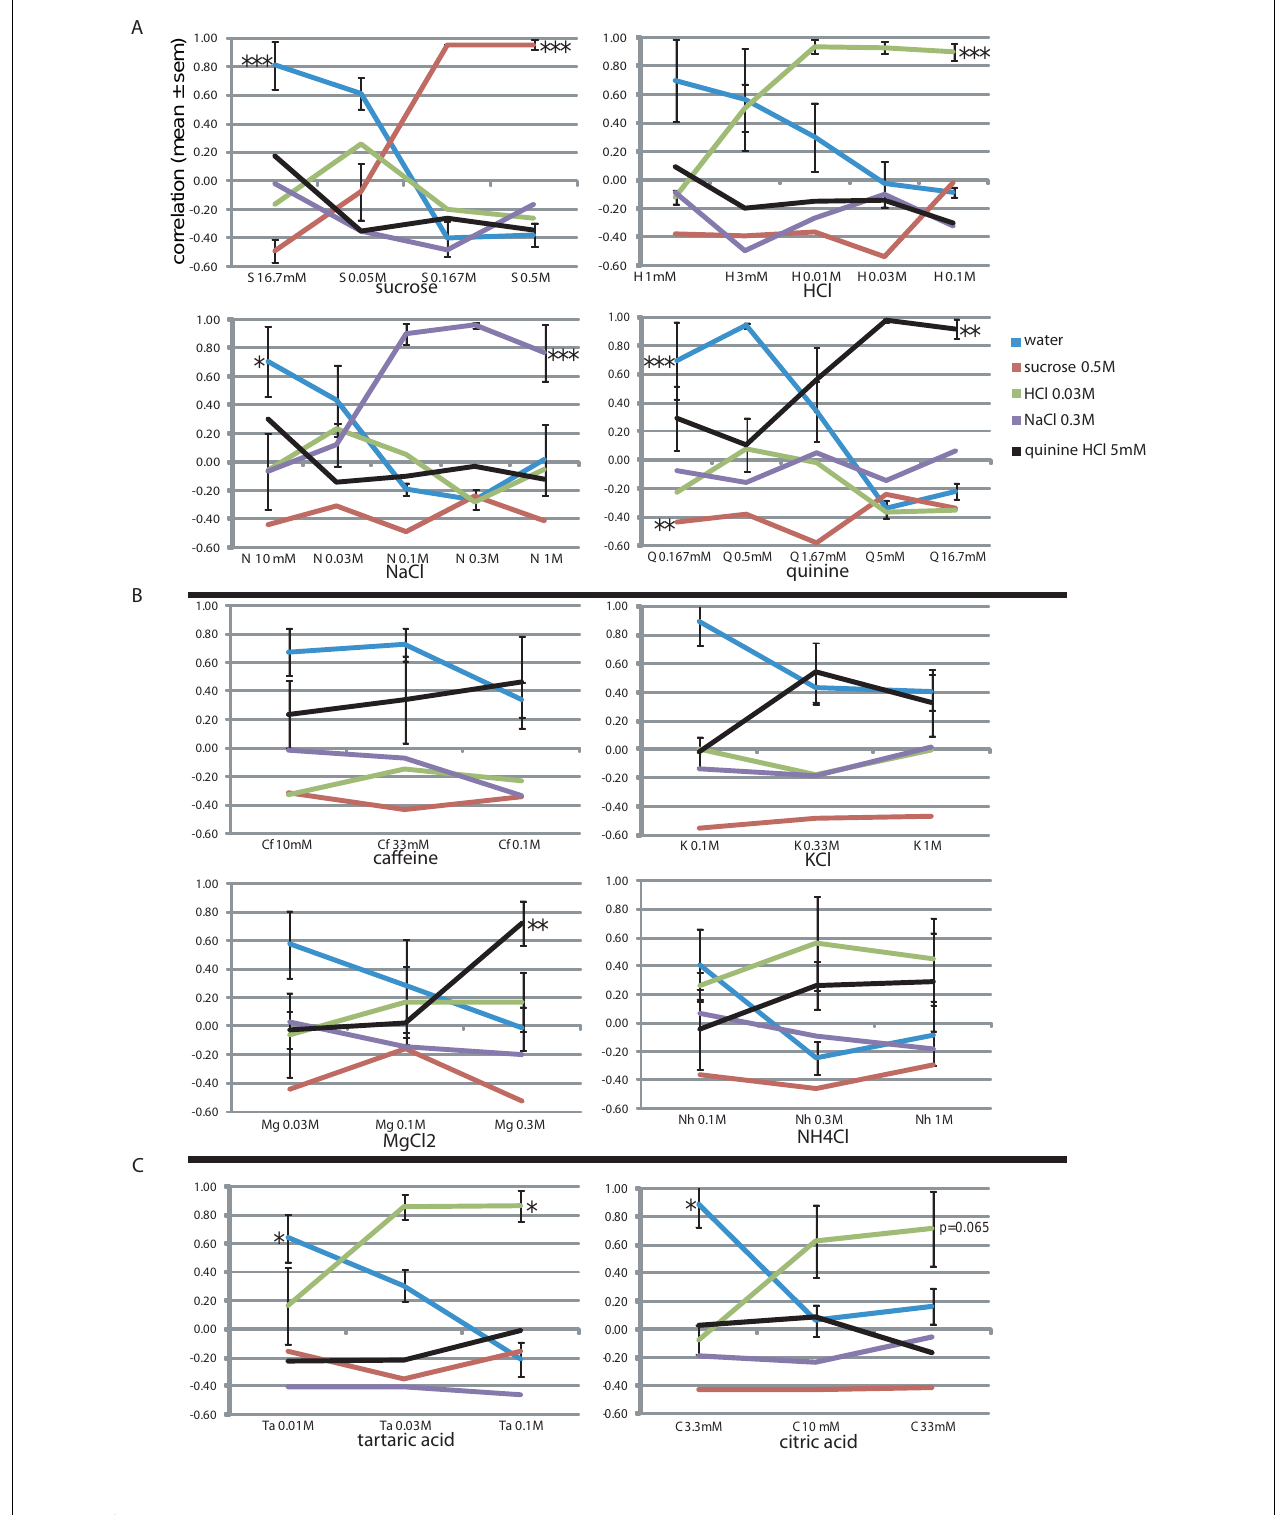
FIGURE 3 | Concentration–response generalization curves. The correlation-based similarity between the response profile to each stimulus (see Table 6 for abbreviations) at each concentration and each of the stimuli